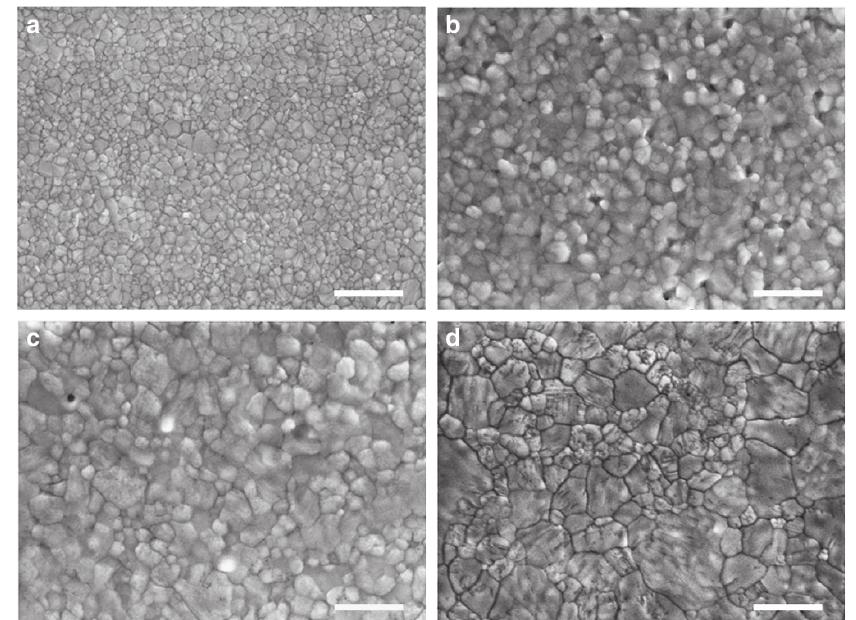
Figure 3 | MABr concentration effect on pinhole-free MAPbI 3 thin films. Top view of SEM images of ( a ) a pinhole-free high-quality MAPbI 3 thin film and those treated with ( b ) 8mgml (cid:2) 1 , ( c ) 4mgml (cid:2) 1 , and ( d ) 2mgml (cid:2) 1 MABr solutions. Scale bars, 1 m m.